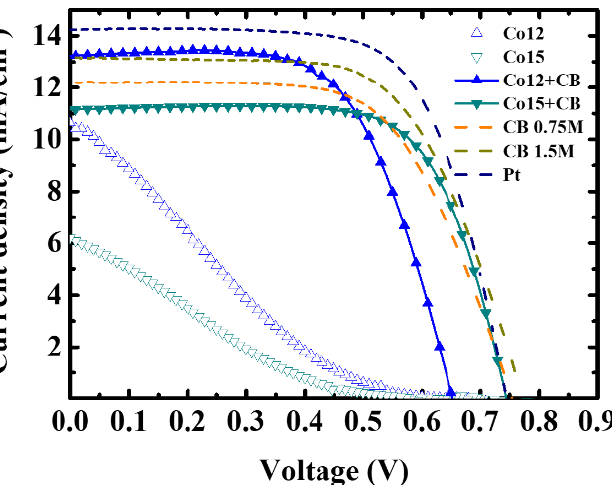
Figure 4. J–V characteristics of DSSCs with cobalt derivatives mixed with CB as CEs.